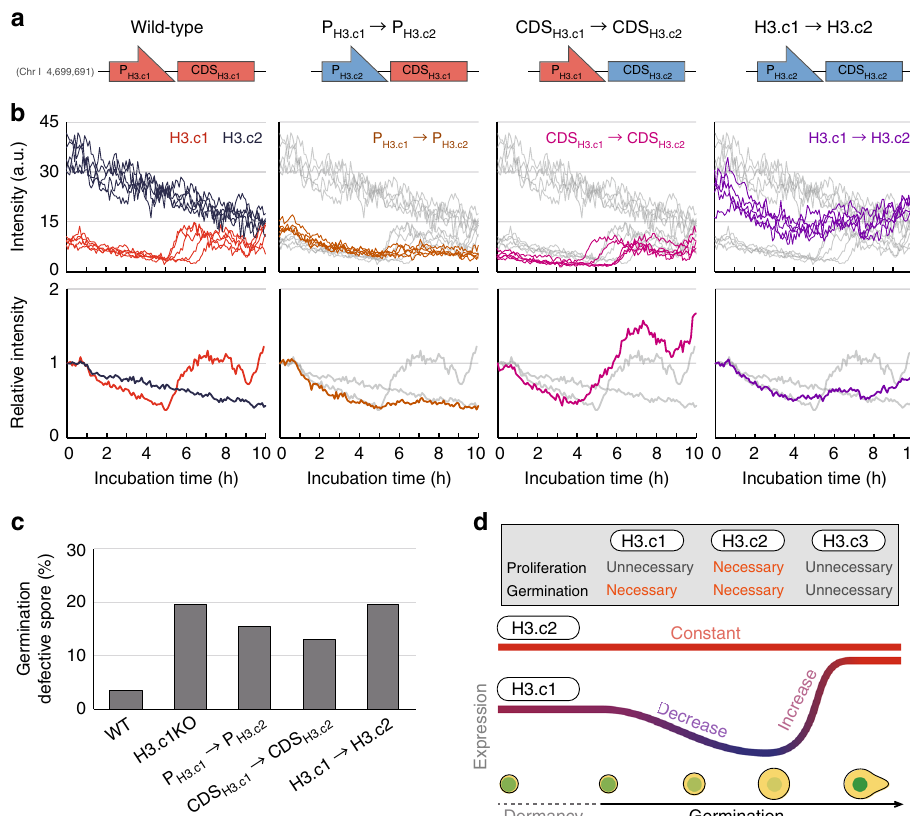
Fig. 5 Control of H3.c1 expression by its promoter is key for fl uctuation. Temporal changes in the levels of the various histone H3 proteins are controlled by their promoters (P) and coding sequences (CDS). a Schematics illustrating states of H3.c1 and H3.c2 gene loci used in this study. For example, P H3.c1 → P H3.c2 : the strain in which the promoter of H3.c1 (P H3.c1 ) was replaced with that of H3.c2 (P H3.c2 ); H3.c1 → H3.c2: both P and CDS were exchanged. b Fluorescence intensity of GFP was measured over time. Top, absolute values are shown; bottom, intensities were normalised to values at time 0 (start of observation). Intensities of WT H3.c1-GFP (red) and H3.c2-GFP (dark blue) are shown to the left, which are also copied onto other graphs (grey traces). Similarly, P H3.c1 → P H3.c2 -GFP (brown), CDS H3.c1 → CDS H3.c2 -GFP (magenta), and H3.c1 → H3.c2-GFP (purple) are shown. c Arti fi cial alteration of H3.c1 expression caused defects in germination. n > 70 spores, N = 2 independent experiments. Values averaged in the graph are given below. WT, 2.3% and 4.7%; H3.c1KO, 23.4% and 15.8%; P H3.c1 → P H3.c2 , 11.6% and 19.3%; CDS H3.c1 → CDS H3.c2 , 10.8% and 15.2%; H3.c1 → H3.c2, 18.9% and 20.3%. d A model for histone H3.c1 expression for ef fi cient germination. Expression decreases once in the initial stage but is substantially boosted in the later stages of germination. Source data are provided as a Source Data fi